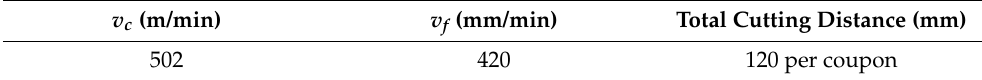
Table 1. Up milling-Cutting conditions.